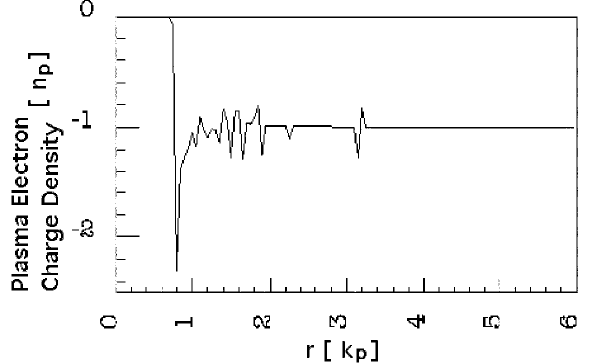
FIG. 2. A radial lineout of the background plasma electron charge density at the center of the beam after 1.4 m of